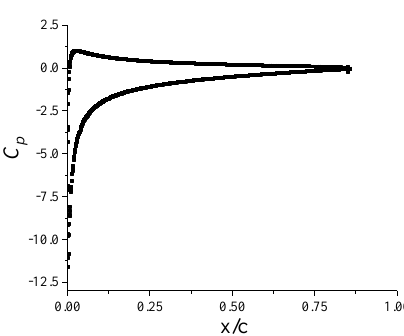
Figure 22. Surface pressure distribution of the hydrofoil when α = 12°.